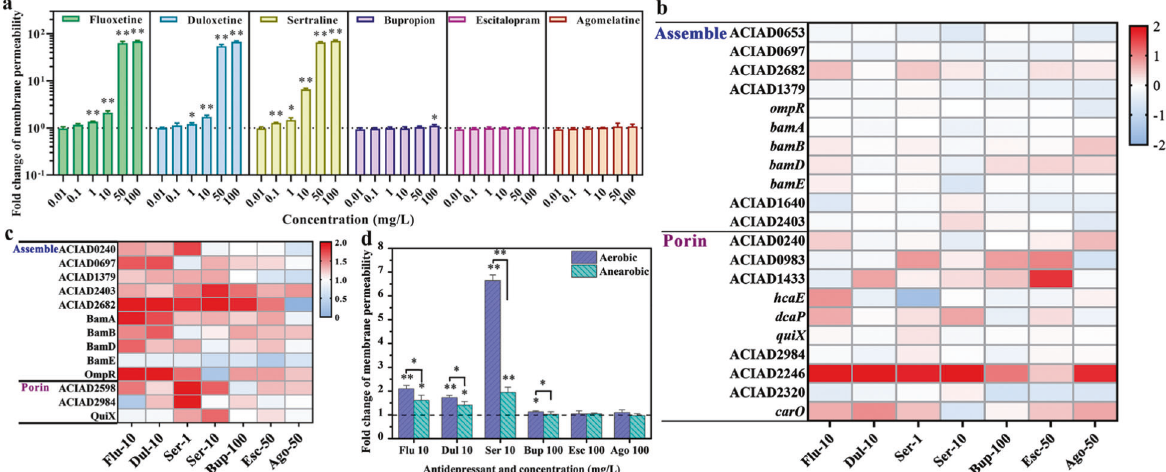
Fig. 3 Antidepressants increase the cell membrane permeability of A. baylyi ADP1. a Cell membrane permeability of A. baylyi ADP1 after 6 h treatments of various antidepressants ( n = 9). Heat-maps showing the transcriptional changes ( b ) and translational changes ( c ) of outer membrane assemble and porin-related genes under the exposure to various antidepressants ( n = 3). d Comparisons between antidepressants-mediated membrane permeability under aerobic and anaerobic conditions ( n = 9). Signi fi cant differences between individual antidepressant-treated groups and the control groups (0 mg/L) were analysed with ANOVA and shown with * ( p adj < 0.05) or ** ( p ad j < 0.01). P values were corrected by the Benjamini/Hochberg